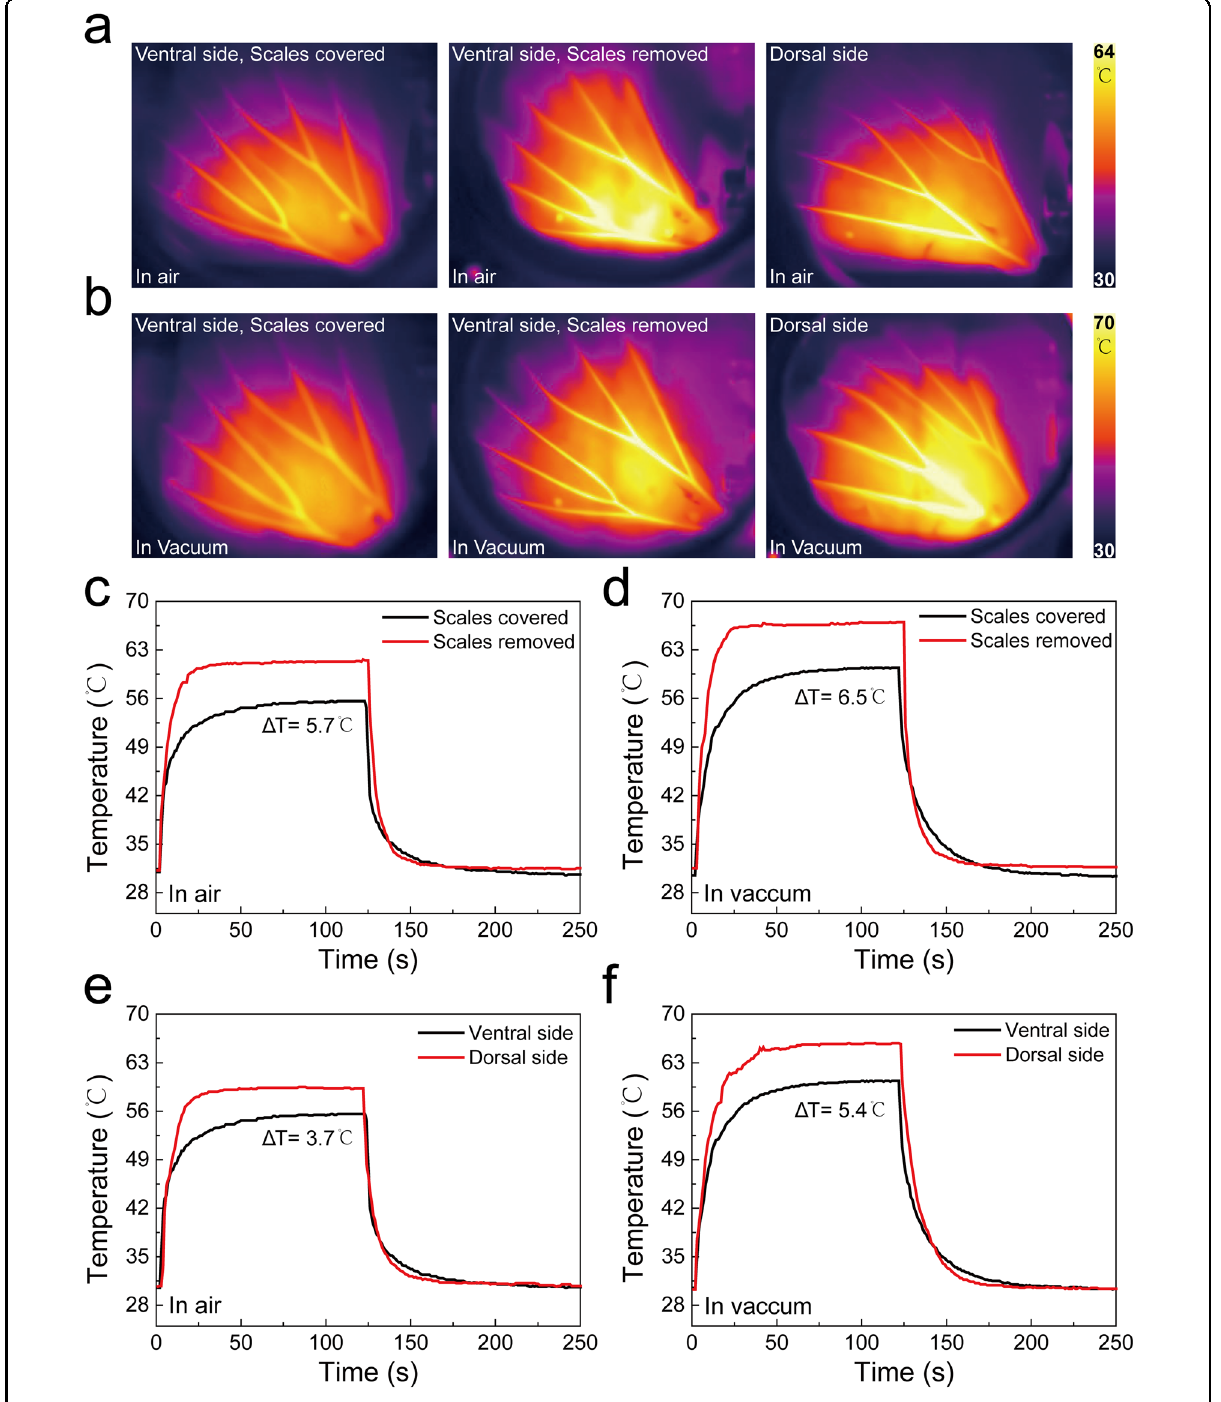
Fig. 6 Thermodynamic experimental results. a Thermal camera images of the scales of the ventral side of the wing covered and removed and of the dorsal side in still air. b Thermal camera images of the scales of the ventral side of the wing covered and removed and of the dorsal side under vacuum. c , d Temporal temperature pro fi les of the wing covered with scales and with scales removed under air and vacuum conditions, respectively. e , f Temporal temperature pro fi les of the ventral and dorsal sides of the wing under air and vacuum conditions,